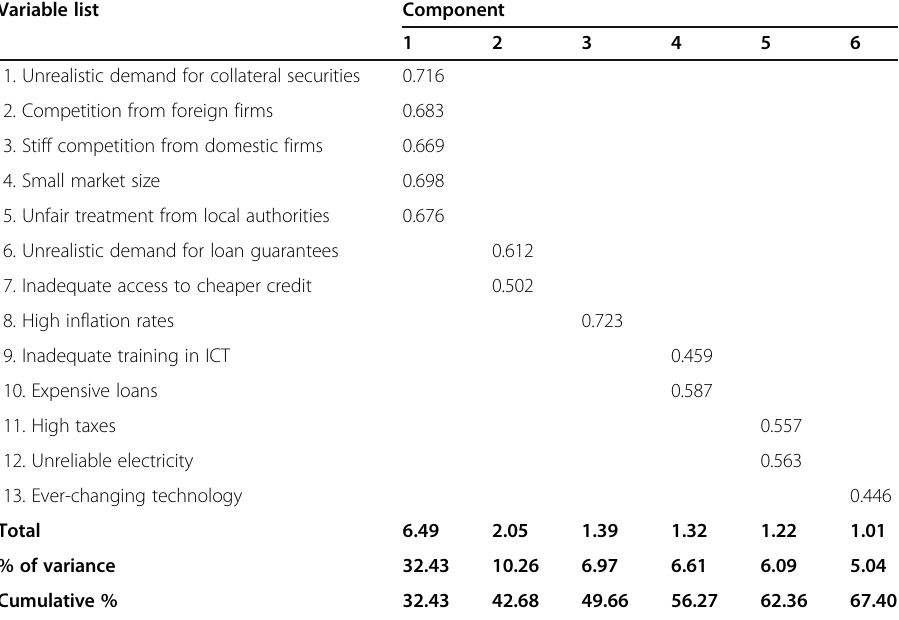
Table 3 Factor analysis on the challenges of SMEs Variable